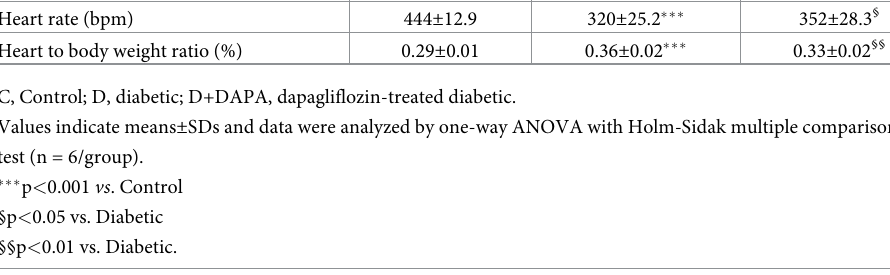
Table 3. Mean arterial pressure, heart rate and heart to body weight ratio. Control Diabetic (D) Heart rate (bpm) 352 ± 28.3 § Heart to body weight ratio (%) 0.29 ± 0.01 0.36 ± 0.02 ��� 0.33 ± 0.02 §§ C, Control; D, diabetic; D+DAPA, dapagliflozin-treated